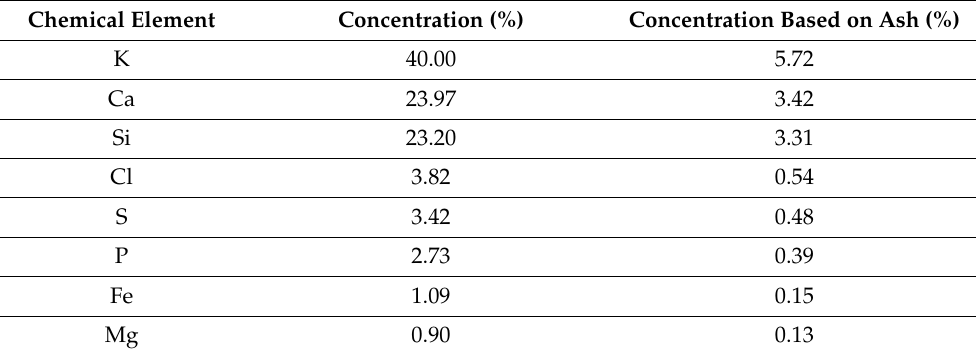
Table 1. Chemical elements found in E. hyemale extract by X-ray fluorescence. Potassium (K), calcium (Ca), silicon (Si), chlorine (Cl), sulfur (S), phosphorus (P), iron (Fe), and magnesium (Mg). Chemical